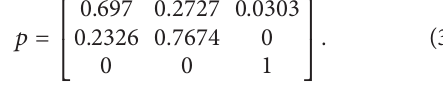
is used to improve the prediction error. For example, the 78 point, the Markov state transition matrix from 1–77 point